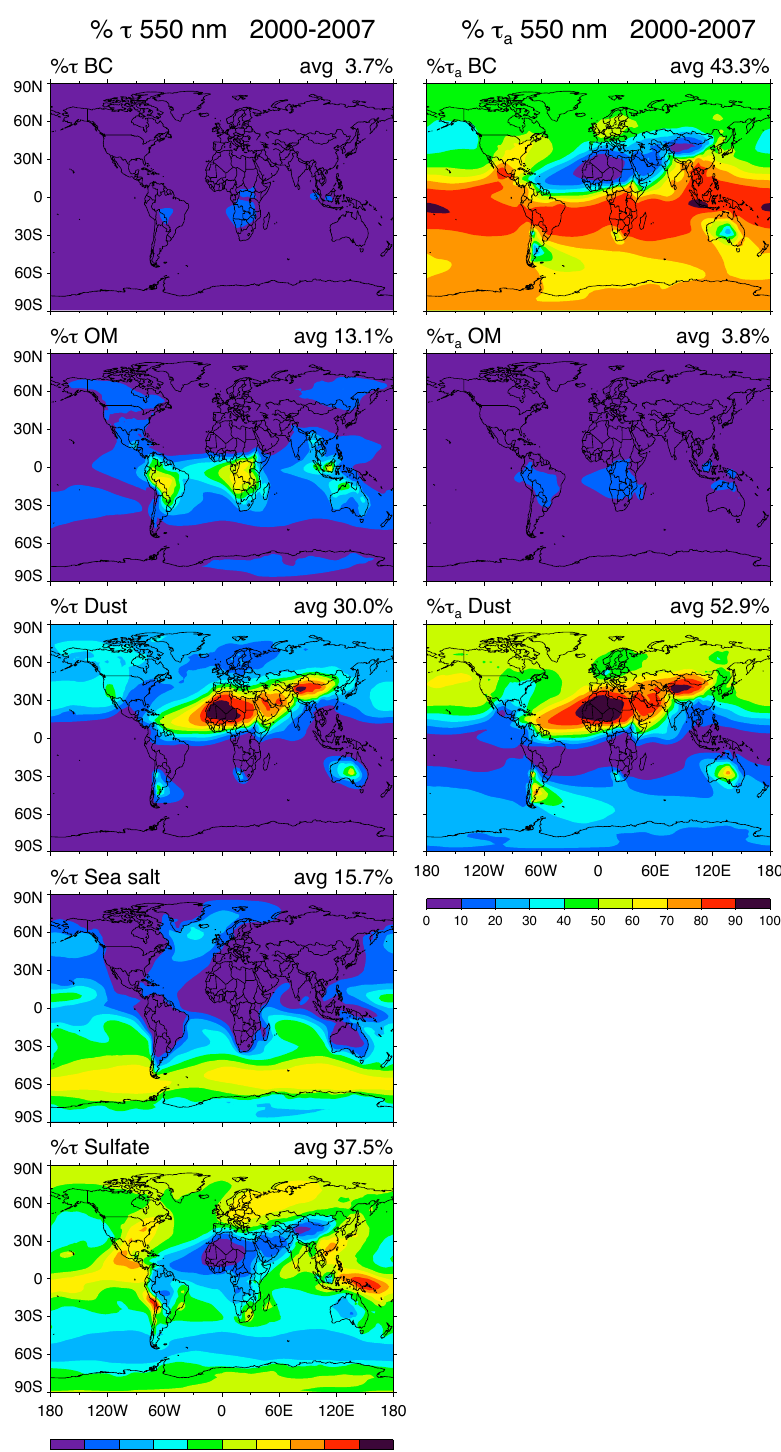
Fig. 9. Left column: Percentage contributions to 550 nm τ from BC, OM, dust, sea salt, and sulfate. Right column: same as the left column but for τ a . Sea salt and sulfate are not shown in the right column because of their zero contributions to τ a